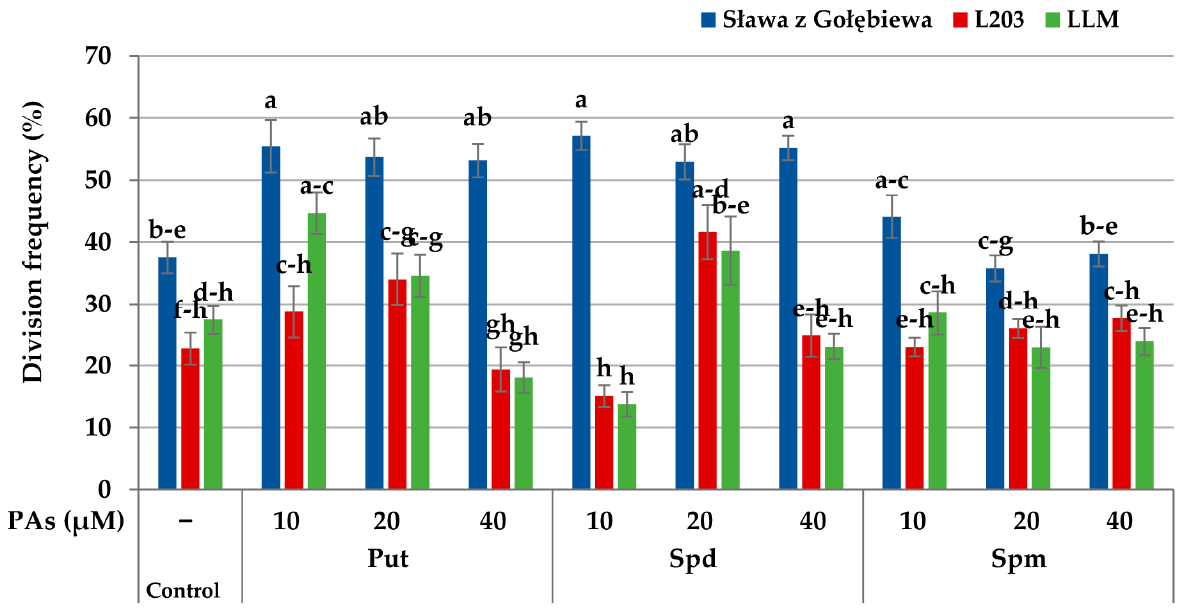
Figure 5. Interaction of the accession and exogenous putrescine (Put), spermidine (Spd), and spermine (Spm) on the division frequency of the protoplast-derived cells of Brassica oleracea L. var. capitata on the 15th day of culture. The bars represent the means ± SE ( n = 60). Values followed by the same letter were not significantly different ( p ≤ 0.05, HSD). Table 3. Mean effect of the accession and exogenous putrescine (Put), spermidine (Spd), and spermine (Spm) on shoot regeneration and ploidy analysis of the regenerants from protoplast-derived callus colonies of Brassica oleracea L. var. capitata. The values for the percentage of regeneration are the means ± SE ( n = 20). Values followed by the same letter were not significantly different ( p ≤ 0.05,